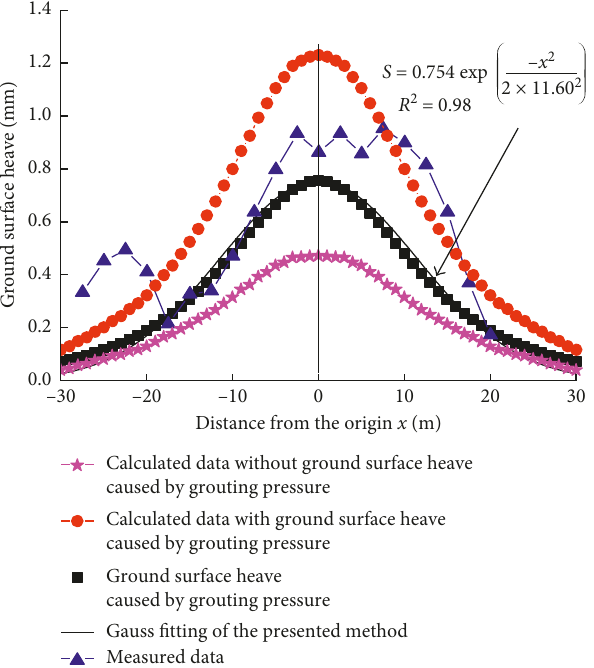
Figure 5: Ground surface settlement caused by the shield tunnel.